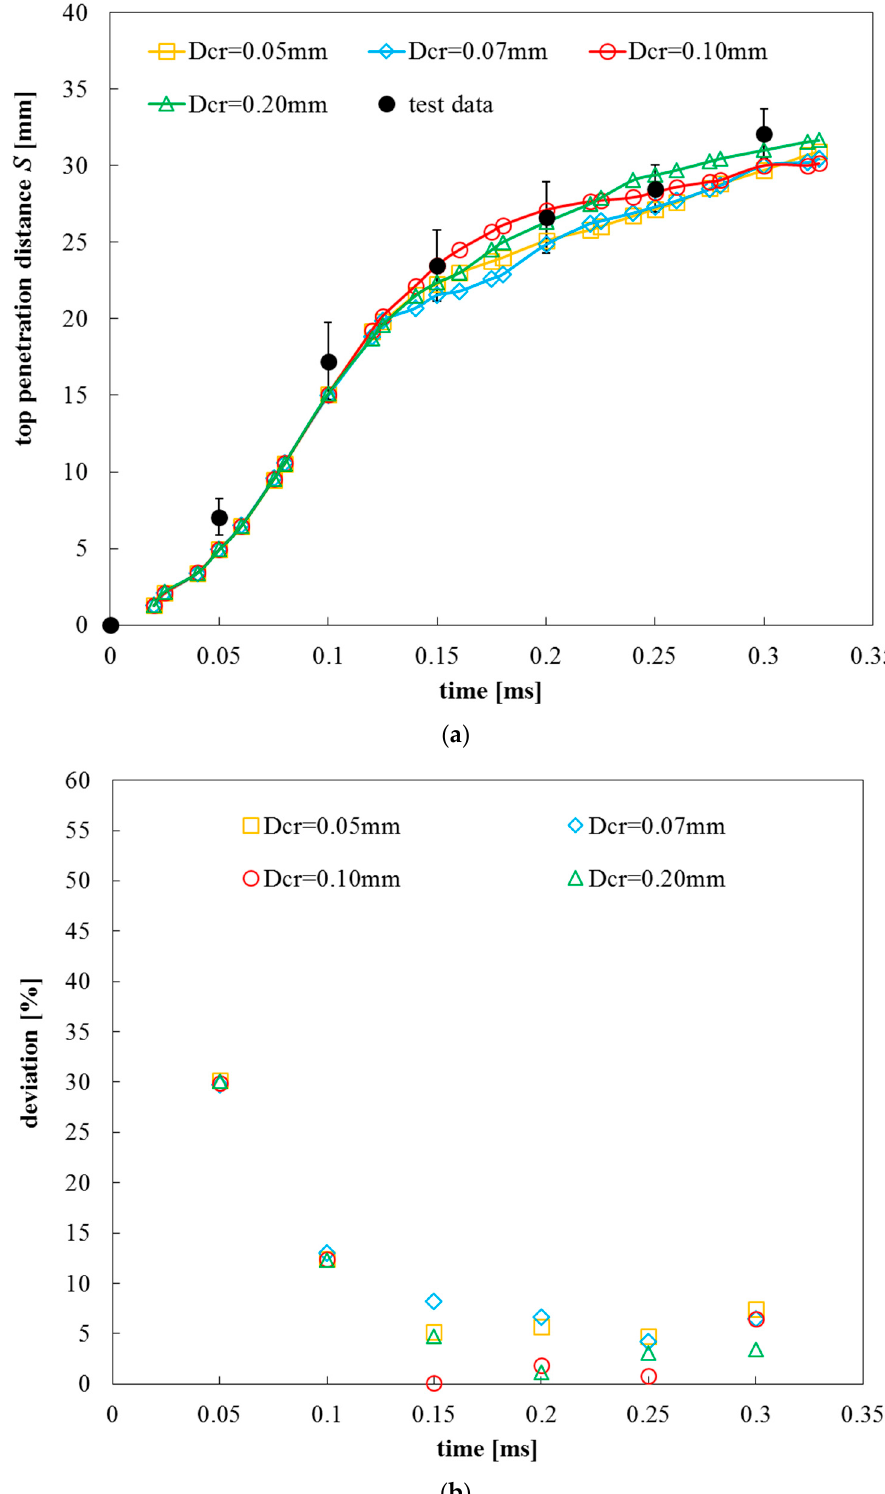
Figure 6. Model validation. ( a ) The top penetration distance S for different transition standards ( D cr ); ( b ) The deviations in the model.